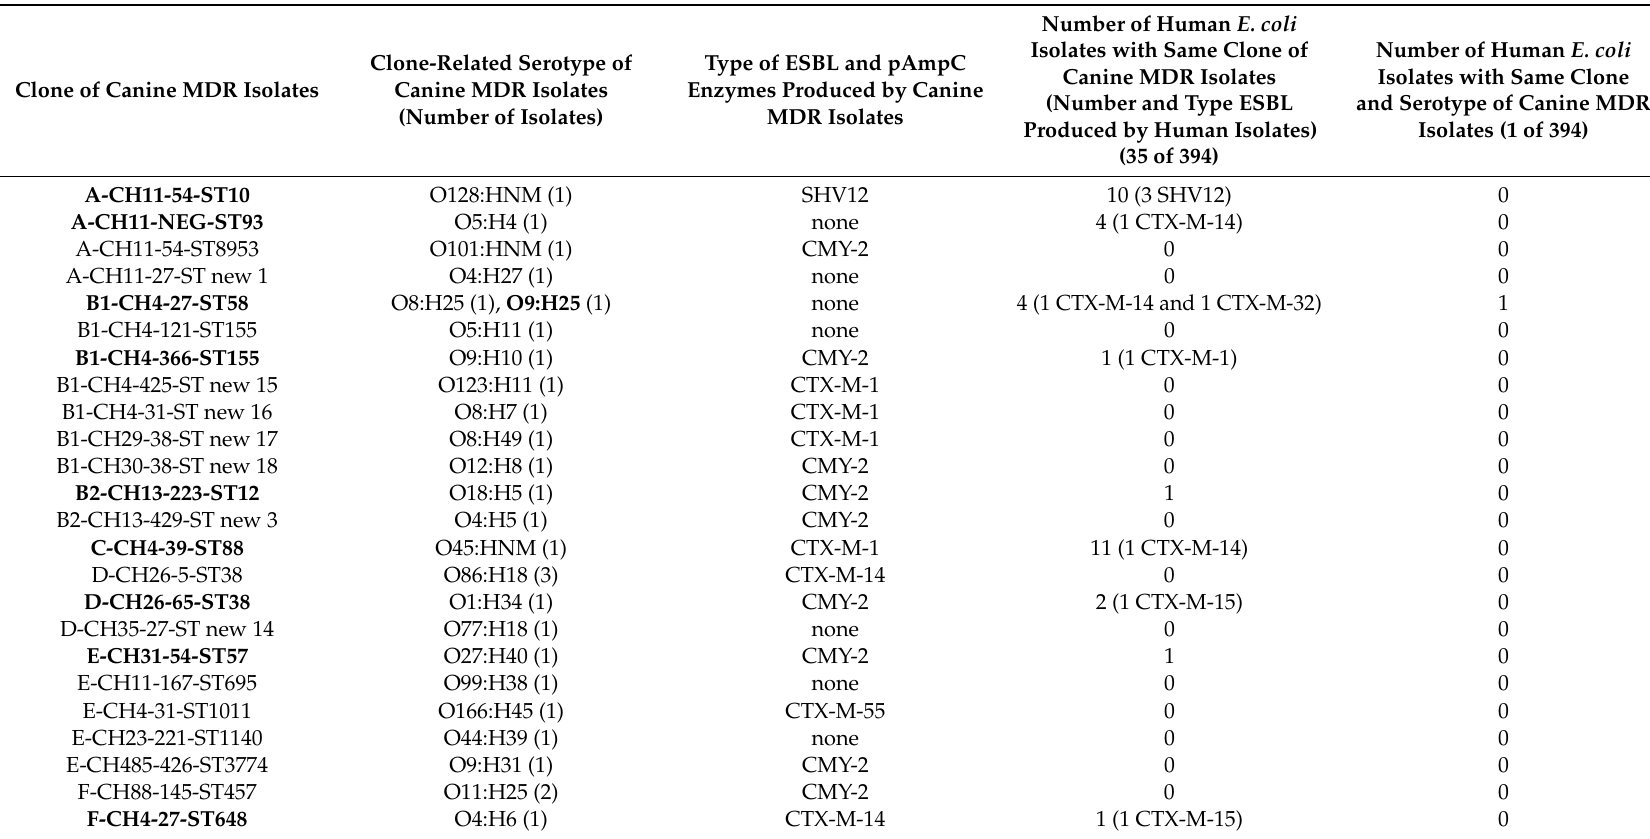
Table 4. Clones and clonal-related serotypes of 28 canine multidrug resistant (MDR) E. coli isolates. Prevalence of the canine clones and clone-related serotypes among E. coli isolates causing extraintestinal infections in humans